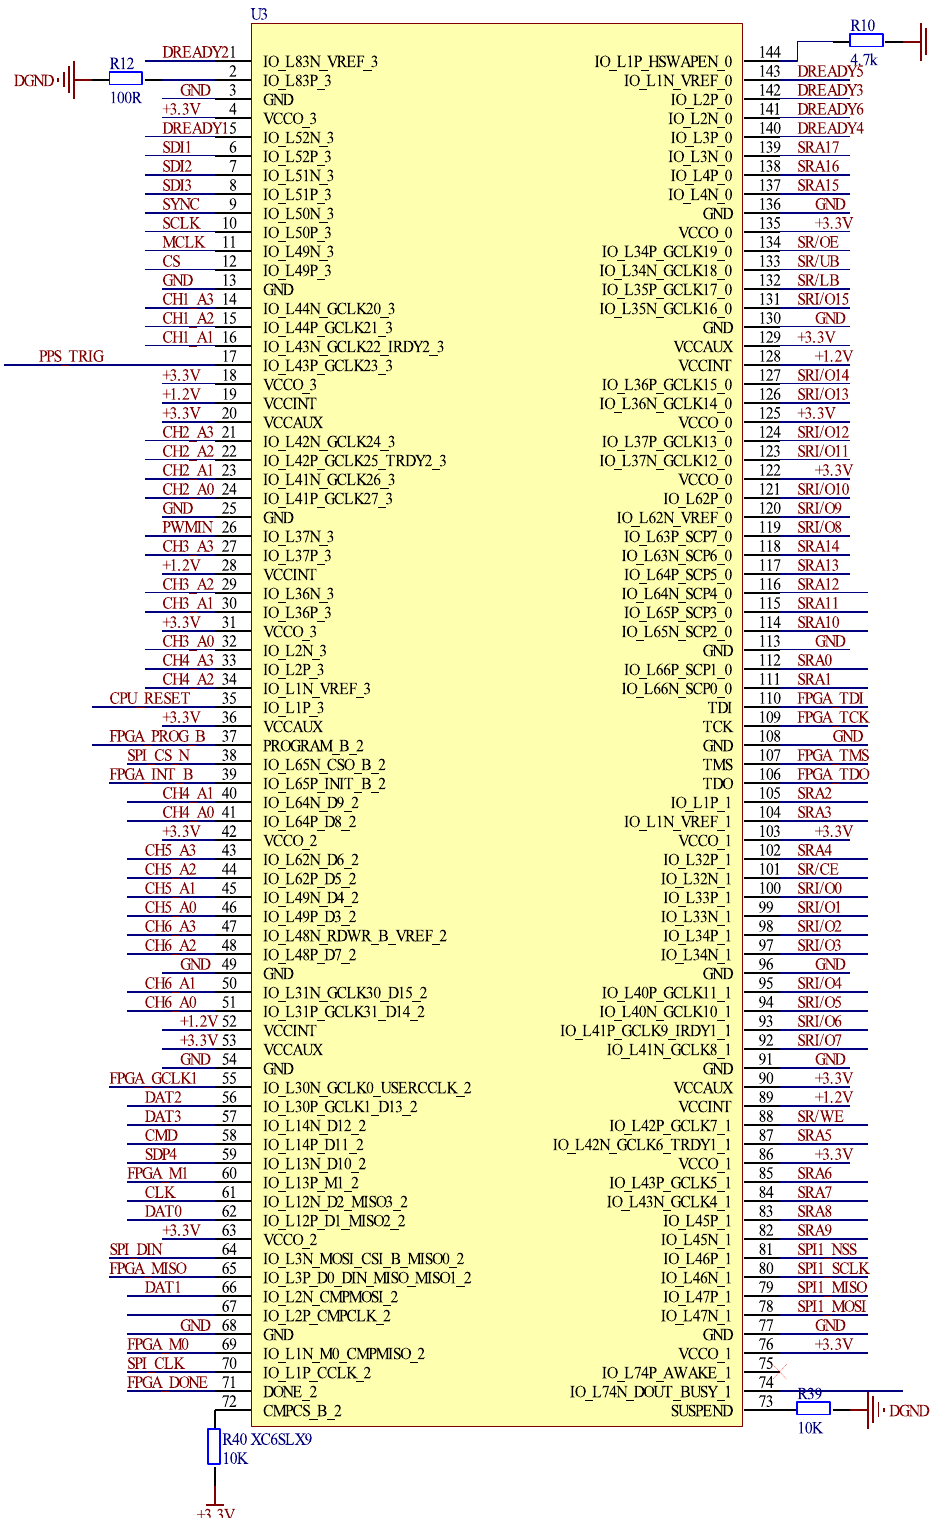
Figure 7. FPGA controller unit